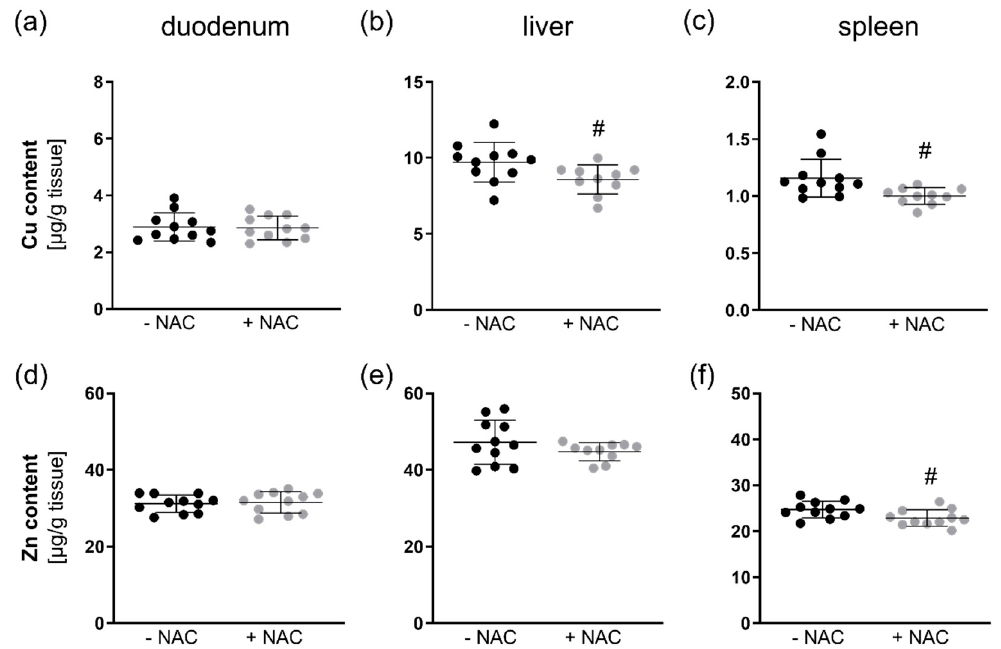
Figure 4. Zn and Cu concentrations in di ff erent organs of NAC-treated mice. Four-week-old male mice (C57BL / 6Jrj) chronically received NAC for 20 weeks via the drinking water (1 g NAC / 100 mL). The Cu and Zn content in ( a , d ) duodenum, ( b , e ) liver, and ( c , f ) spleen was measured using total reflection X-ray fluorescence (TXRF) spectroscopy. The data are shown as mean ± SD and were calculated by unpaired t-test. # p < 0.05 vs. − NAC (NAC effect).